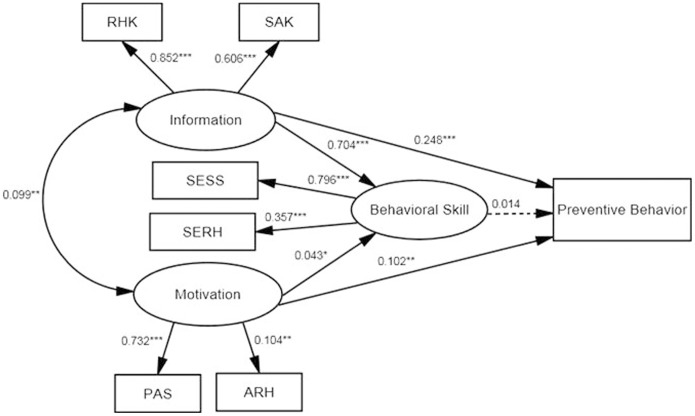
The preliminary IMB model predicting preventive behavior among 944 unmarried rural-to-urban female migrants.Oval represent multiple-indicator latent variables, rectangle represent single-indicator observable variables. Single-headed arrow represent regression path, double-headed arrows represent correlations. Regression coefficients are standardized (* p<0.05, ** p<0.01, *** p<0.001). Dotted line indicates non-significant path from original IMB model.